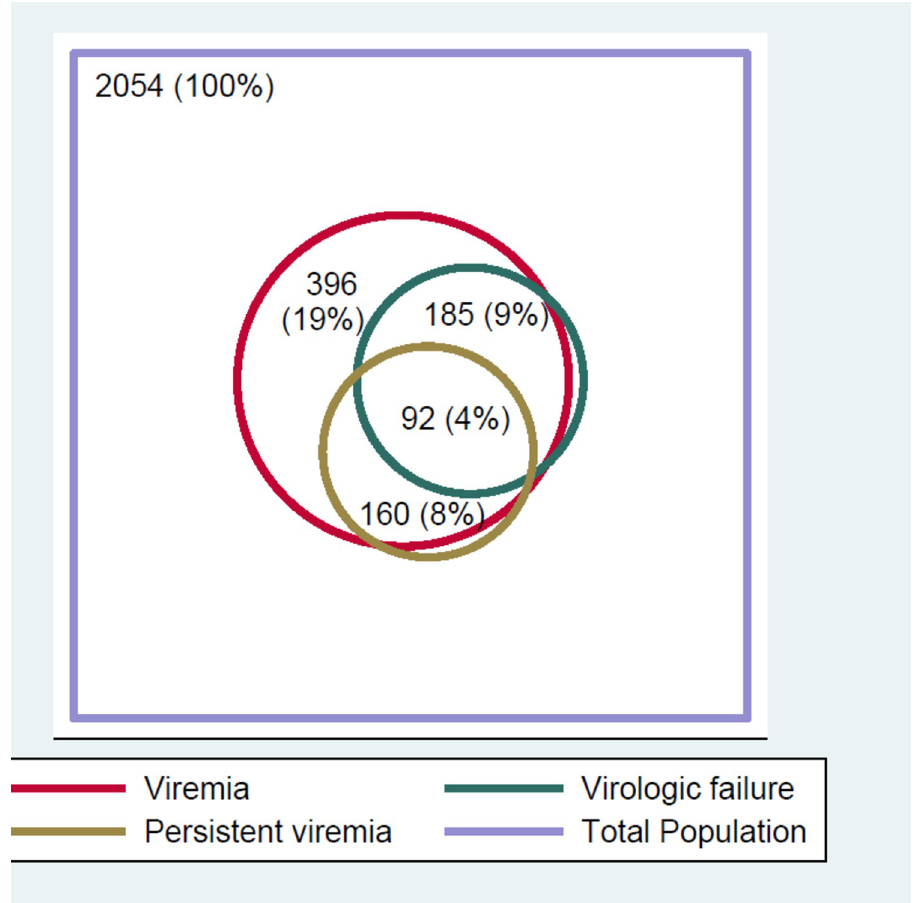
Fig 3. Overlap of participants with different thresholds of